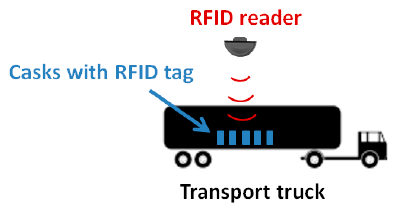
Figure 8. Example of an RFID tracking system.